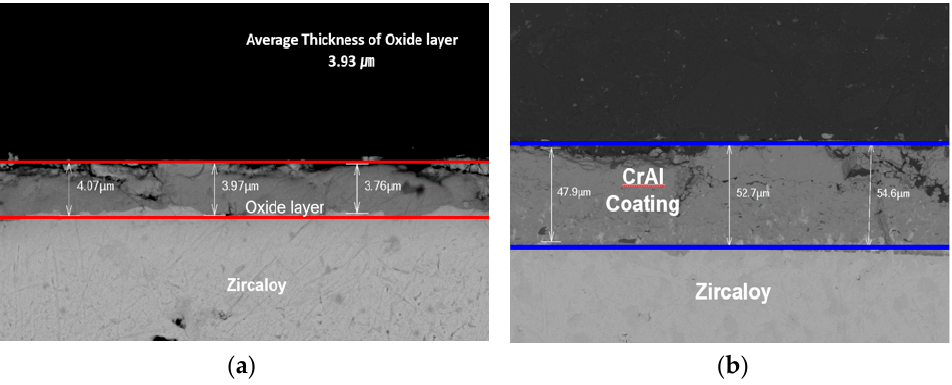
Figure 4. SEM photographs after quenching test for; ( a ) Zr cladding; ( b ) CrAl-coated Zr cladding.